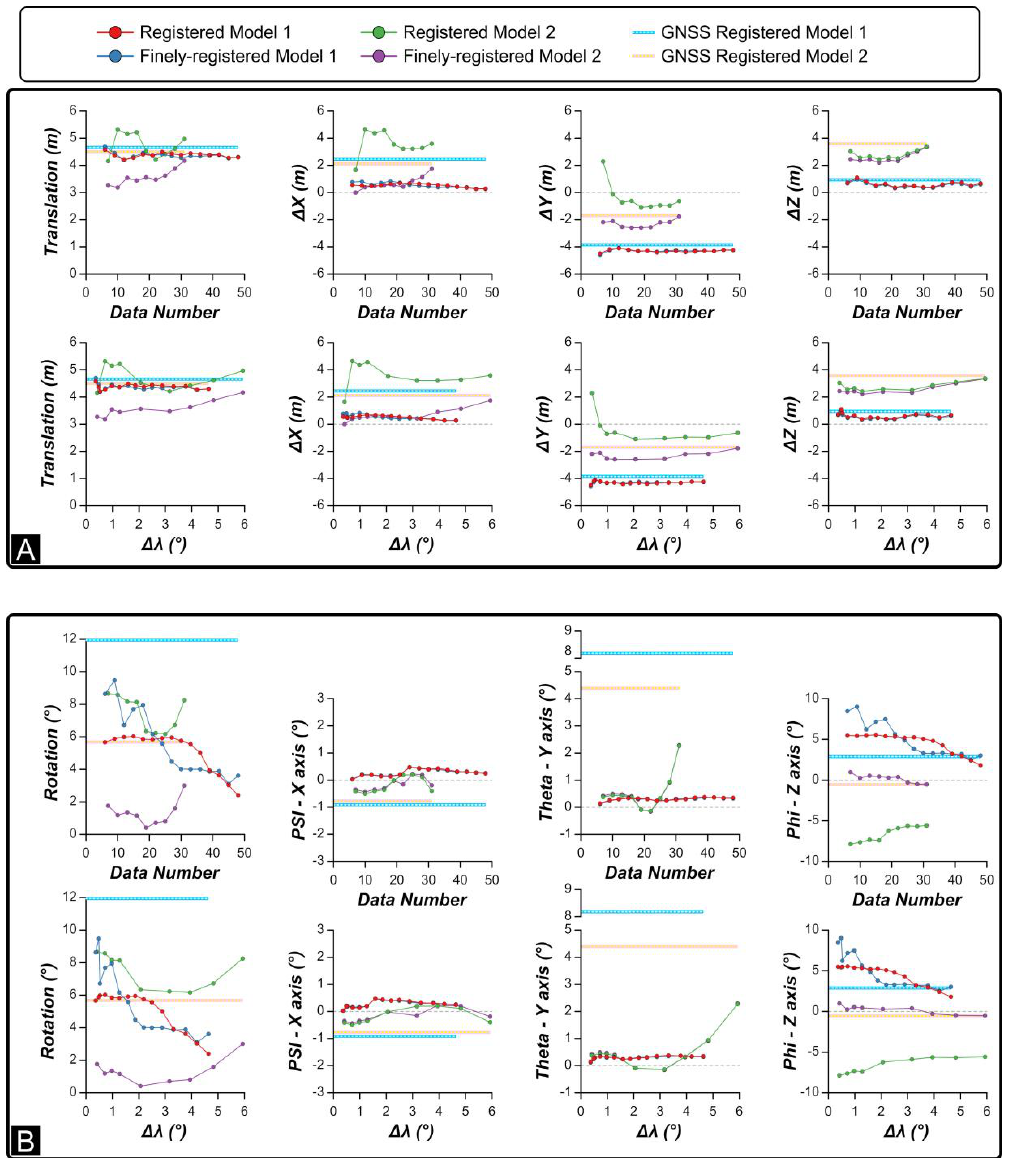
Figure 8. Mismatch between registered and ground truth smartphone models for the different sub- models. ( A ) Translation and ( B ) rotation needed to perfectly align the smartphone sub-models to the corresponding ground truth model. The plots also include the mismatch between the ground truth models and the model registered using the GNSS position (without using camera orientation infor- mation).